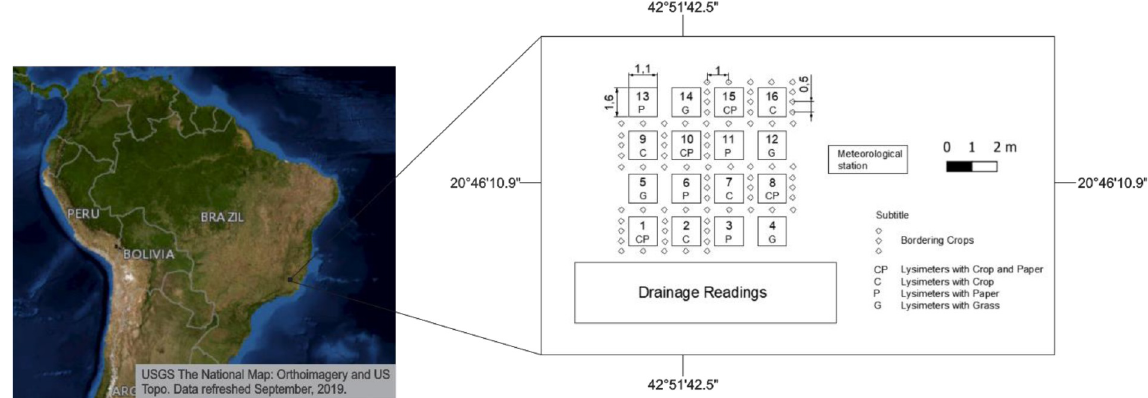
Fig 1. Sketch of the experimental area with the imposed treatments. Vic¸osa-MG, DEA-UFV, 2017–2018.